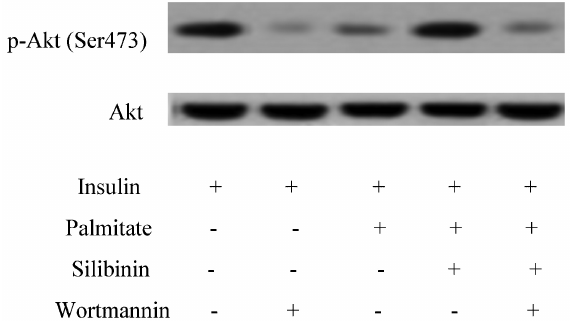
Figure 5. The increase of Akt phosphorylation by silibinin in insulin-resistant C2C12 myotubes was suppressed by 50 nM wortmannin, a specific inhibitor of phosphatidylinositol-3-kinase (PI3K). Differentiated C2C12 skeletal muscle cells were incu- bated with palmitate (0.75 mM) and/or silibinin (100 m g/mL) in the presence or absence of wortmannin (50 nM), and then stimulated with insulin (100 nM) before cells were harvested for Western blotting. Figures are representative of 3 independent experi-